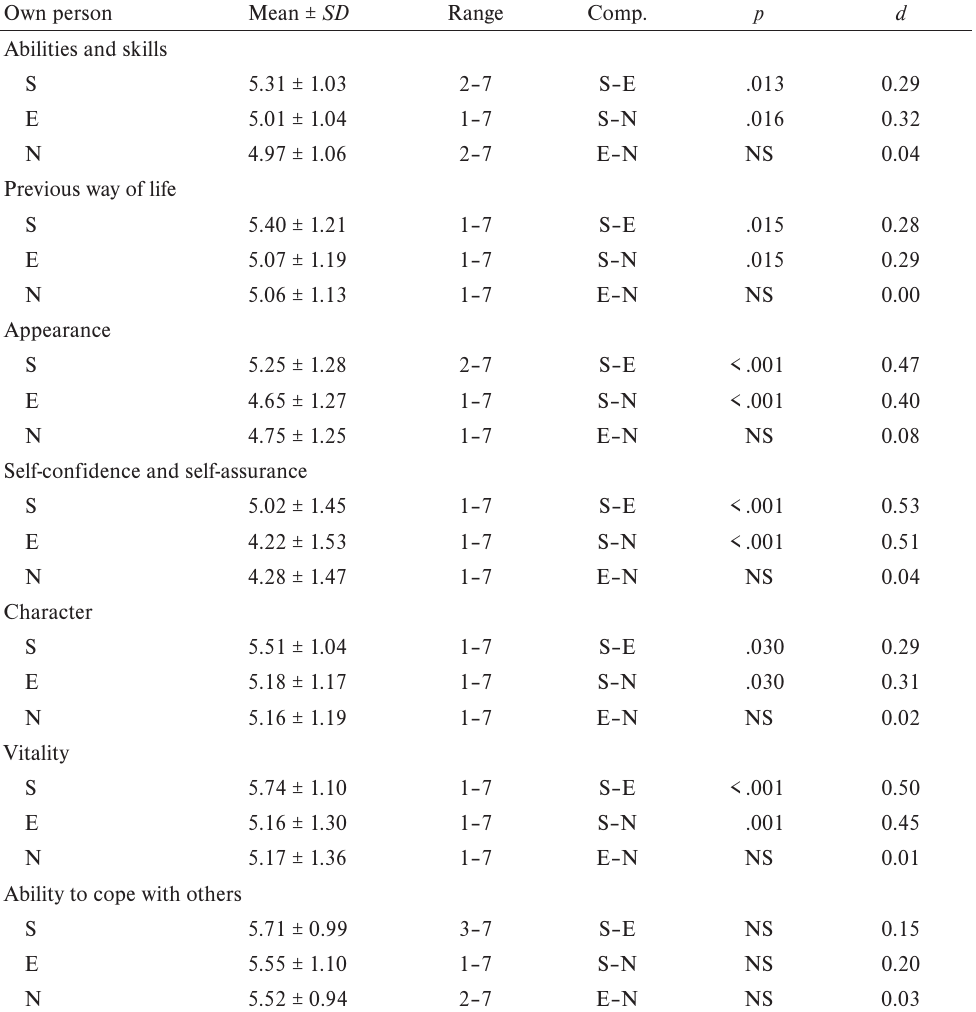
Table 4 Comparison of the subcomponents of satisfaction with own person in current university students with respect to study